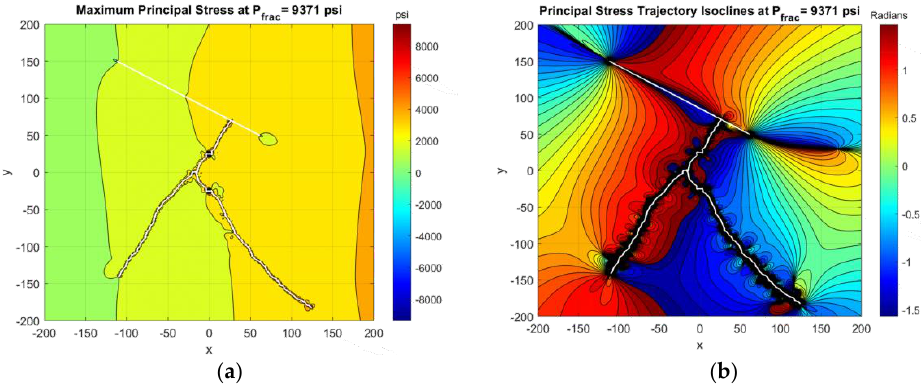
Figure 15. TLSM results at the end of injection showing ( a ) maximum principal stress, and ( b ) principal stress trajectory isoclines at t = 4.583 min. TLSM results were generated in 53.101 s including post-processing.